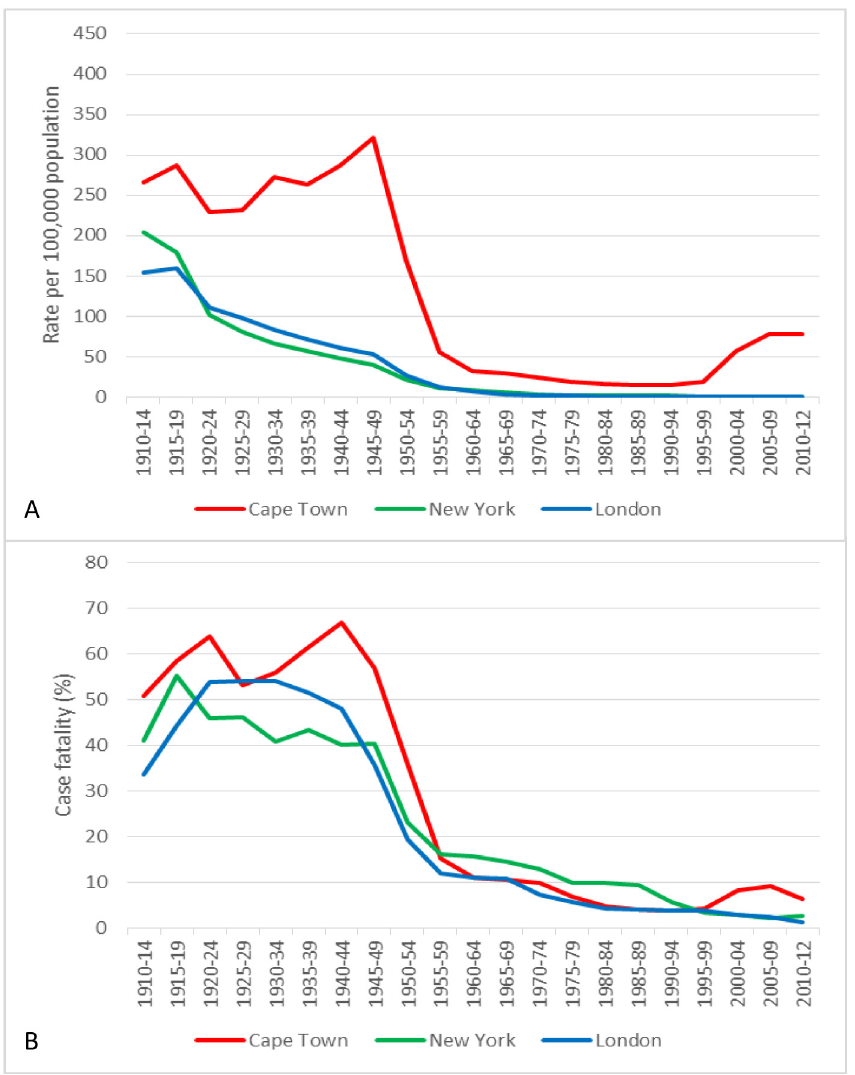
Fig 1. TB mortality and case fatality rates over time. A. TB mortality rates over time. B. TB case fatality rates over time. Note. Rates from 1913 to 1965 are for London County Council (current Inner London) [17], thereafter for the Greater London Area (Inner and Outer London)[23, 24]. CT, Cape Town; NY, New